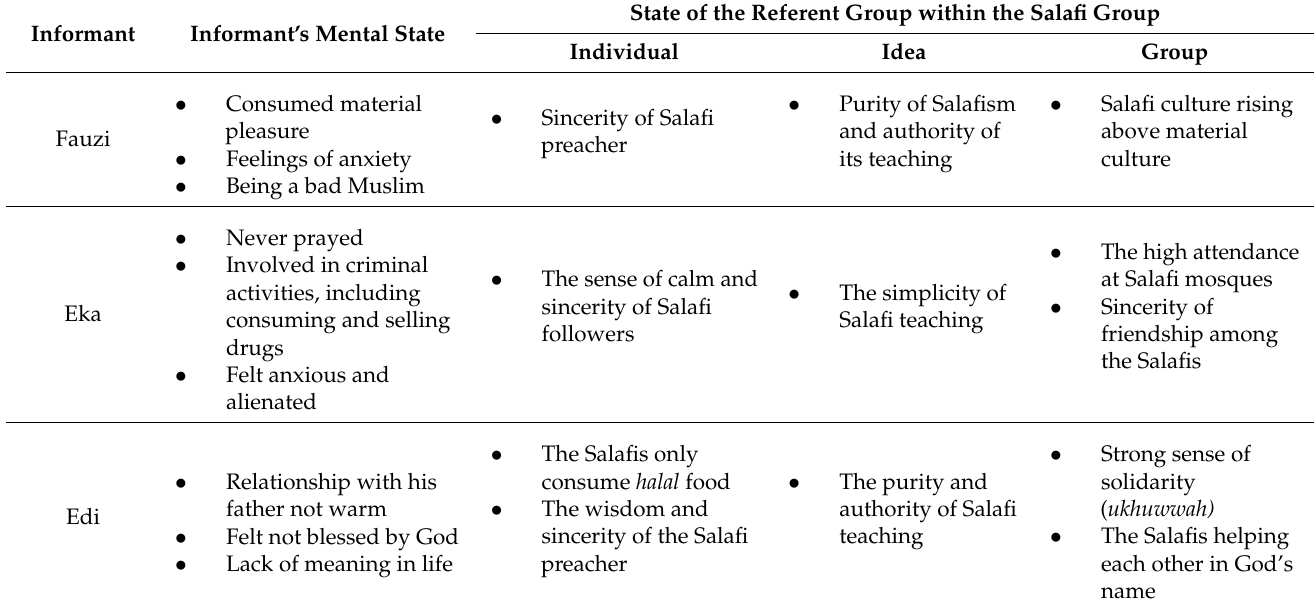
Table 2. Mental state of the informants and comparison with referent groups.